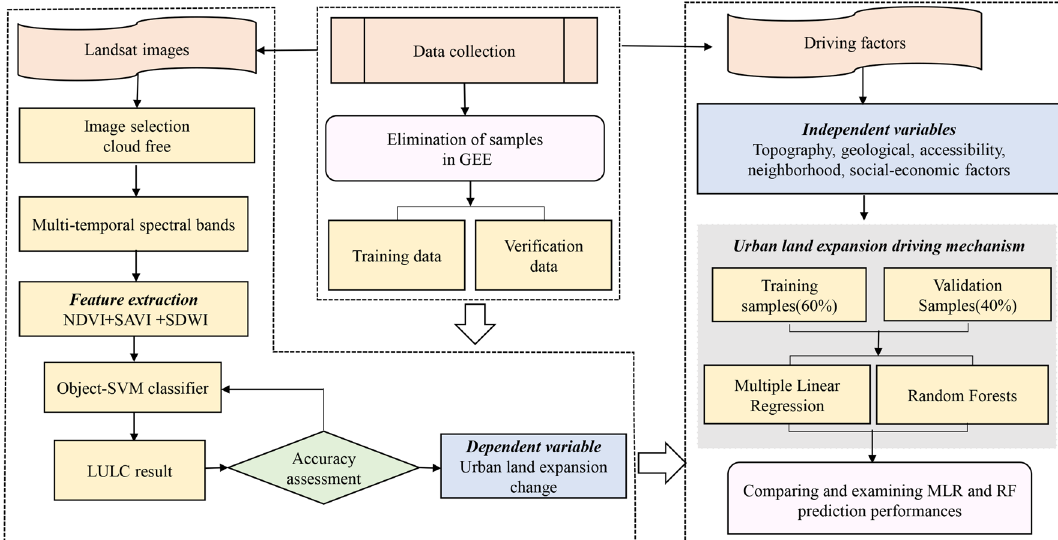
Figure 3. Schematic representation of the research framework. SAVI, NDVI, NDW and LULC represent Soil Adjusted Vegetation Index, Normalized Difference Vegetation Index and Normalized Difference Water Index and land